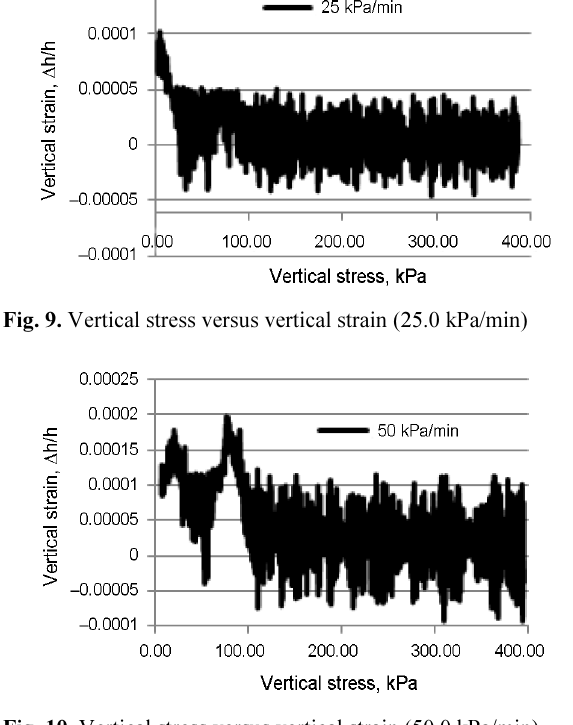
Fig. 10. Vertical stress versus vertical strain (50.0 kPa/min)